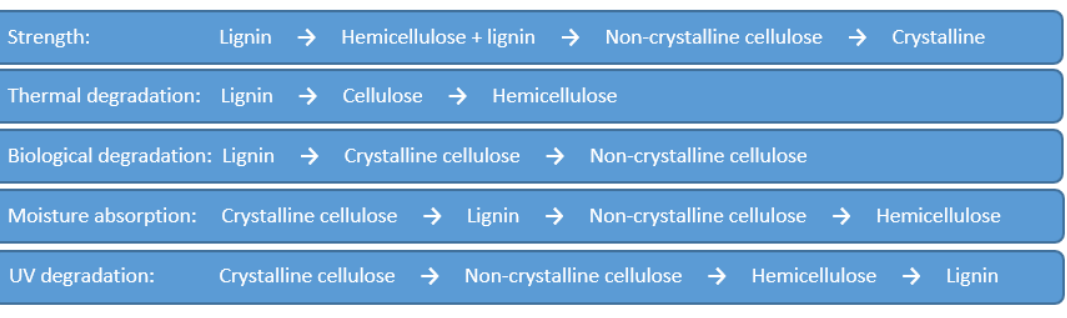
Figure 3. Plant constituents influence. The rightward-pointing arrow indicate an increase. Adapted from: [47].